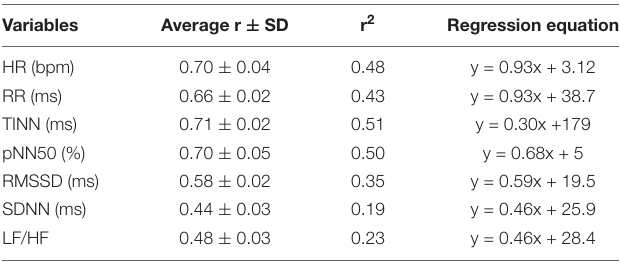
TABLE 3 | Mean values of the correlation coefficients (r) and associated standard deviation were obtained through the bootstrap procedure for each HRV metric